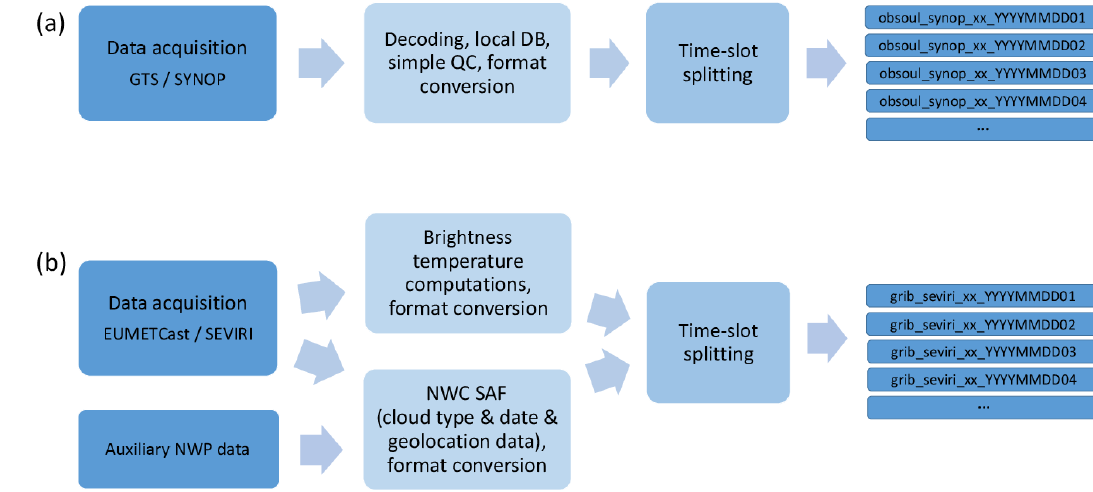
Figure 2. Illustration of observation preprocessing steps for SYNOP (a) and SEVIRI (b)